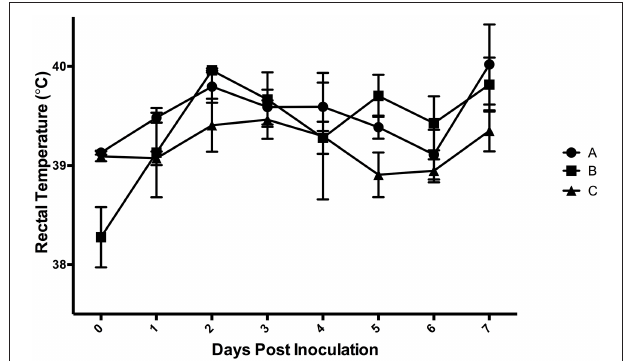
FIGURE 1 | Mean rectal temperatures from animal study #1 following inoculation on DPI 0 with three separate isolates of S. 4,[5],12:i:- (A, B, C). The mean and standard error are represented by the vertical bars.